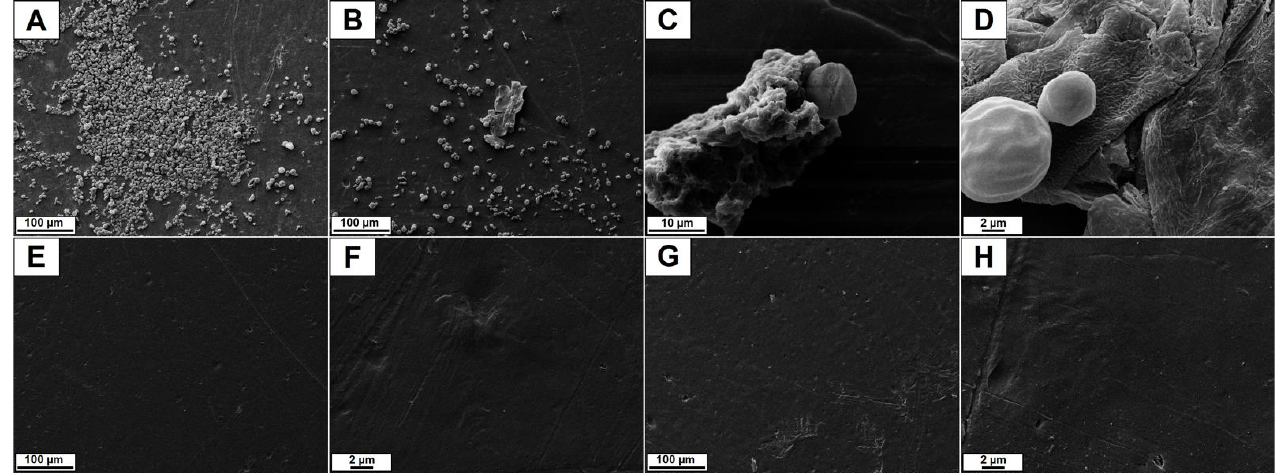
Figure 8. SEM micrographs of ( A ) HDPE (scale bar = 100 μm), ( B ) HDPE (scale bar = 100 μm), ( C ) HDPE (scale bar = 10 μm), ( D ) HDPE (scale bar = 2 μm), ( E ) HDPE.Cl.0500 (scale bar = 100 μm), ( F ) HDPE.Cl.0500 (scale bar = 2 μm), ( G ) HDPE.MeS.0500 (scale bar = 100 μm) and ( H ) HDPE.MeS.0500 (scale bar = 2 μm), after undergoing biofilm growth conditions.